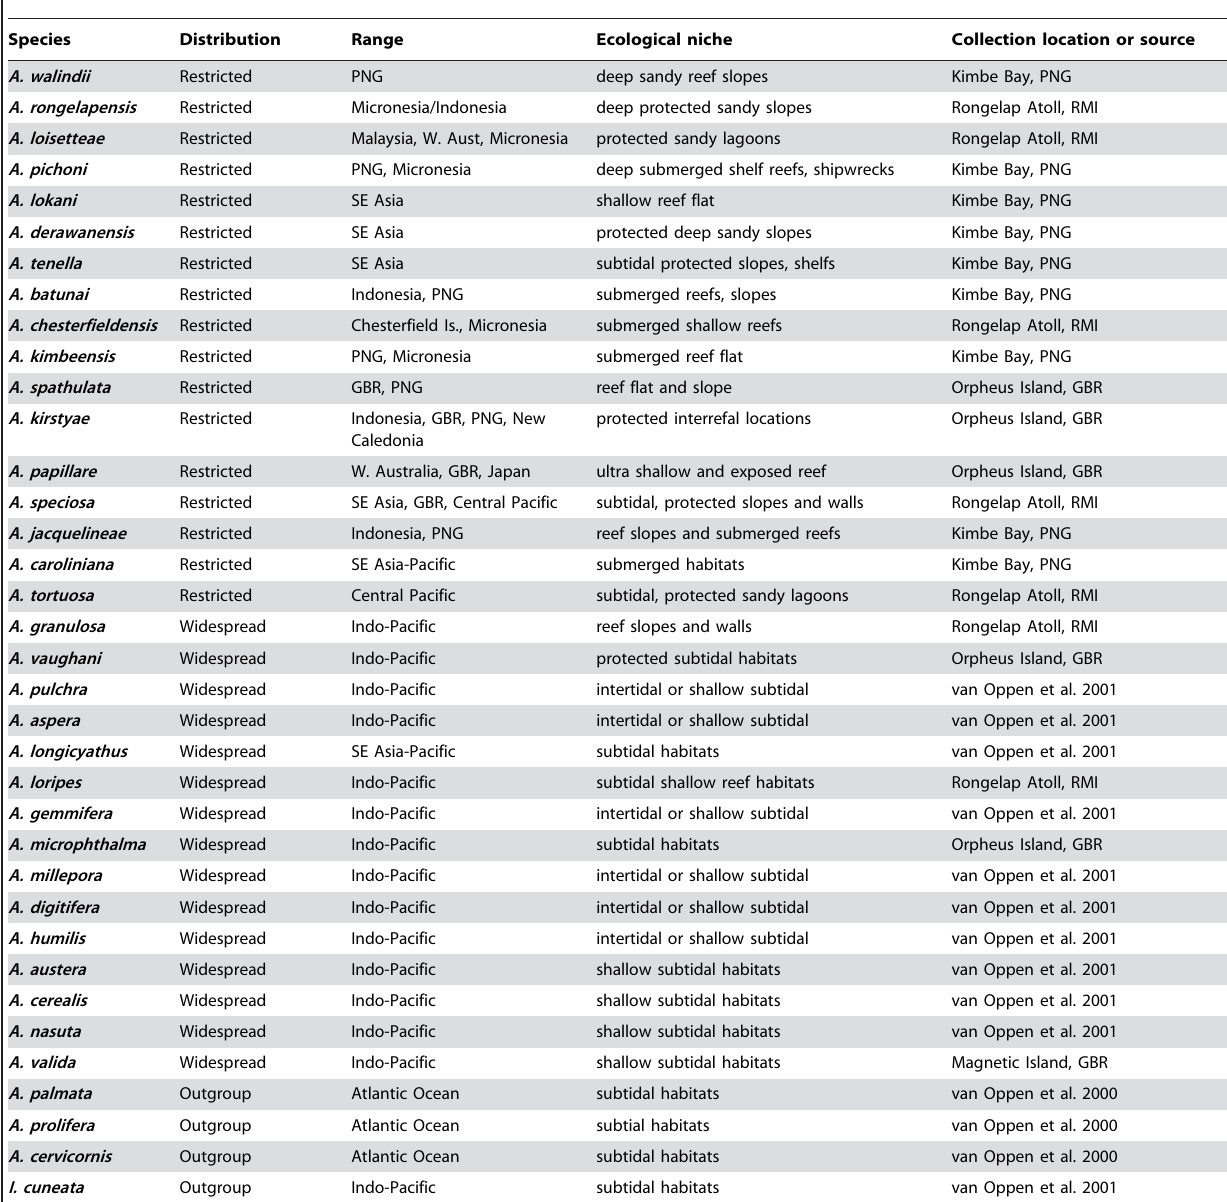
Table 1. Biological characteristics of species included in this